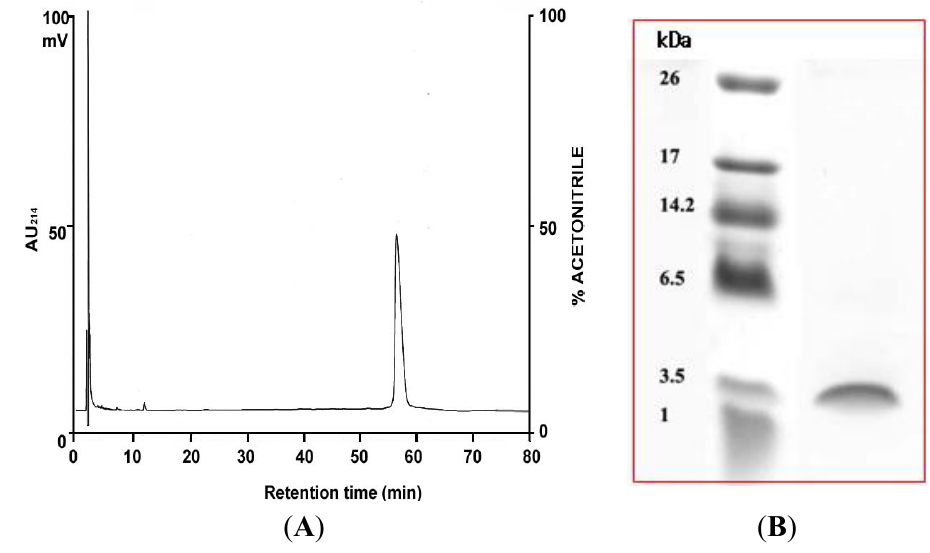
Figure 2. High-performance liquid chromatography (HPLC) profile obtained by re-analyzing peak 5. The protein was eluted using a linear gradient of acetonitrile in 0.1% trifluoroacetic acid (TFA). Absorbance was monitored at 214 nm. ( A ) Peptide-G2 (PG-2) peaks; ( B ) Tricine gel electrophoresis of purified PG-2: lane 1, molecular size